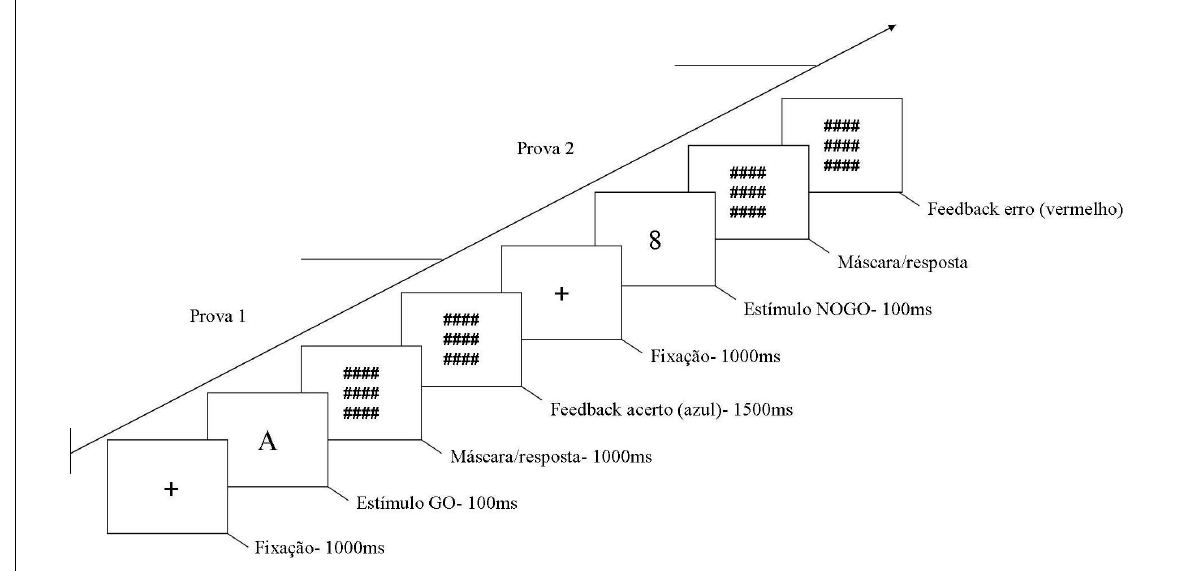
Figura 1 . Representação esquemática da sucessão de provas no teste TDC.